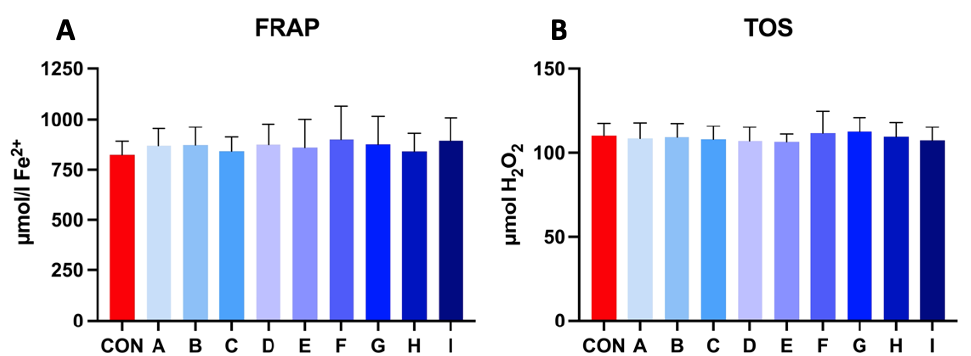
Figure 4. ( A ) The effect of taurine and caffeine on the ferric reducing ability of plasma ( μmol Fe 2+ ) of stallion spermatozoa after 30 h of incubation at 5 °C ( n = 10). ( B ) The effect of taurine and caffeine on the total oxidant status ( μmol H 2 O 2 ) of stallion spermatozoa after 30 h of incubation at 5 °C. CON: 0 mg/mL taurine + 0 mg/mL caffeine; A: 2.5 mg/mL taurine + 0.625 mg/mL caffeine; B: 2.5 mg/mL taurine + 1.25 mg/mL caffeine; C: 2.5 mg/mL taurine + 2.5 mg/mL caffeine; D: 5 mg/mL taurine + 0.625 mg/mL caffeine; E: 5 mg/mL taurine + 1.25 mg/mL caf- feine; F: 5 mg/mL taurine + 2.5 mg/mL caffeine; G: 7.5 mg/mL taurine + 0.625 mg/mL caffeine; H: 7.5 mg/mL taurine + 1.25 mg/mL caffeine; I: 7.5 mg/mL taurine + 2.5 mg/mL caffeine. Each bar represents the mean value of observed samples ( ±